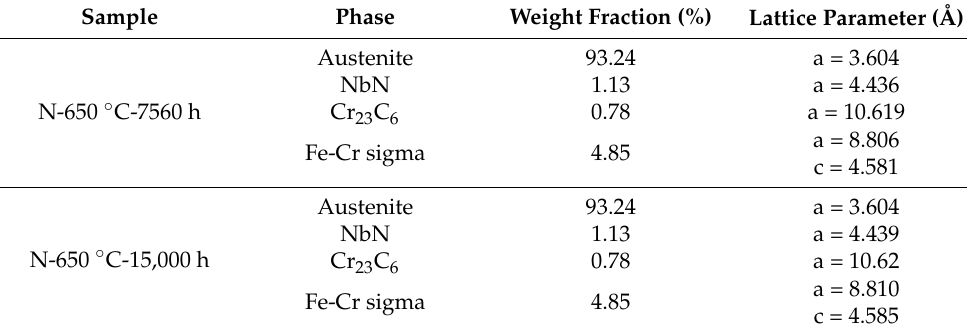
Table 8. Results after the Rietveld refinement.